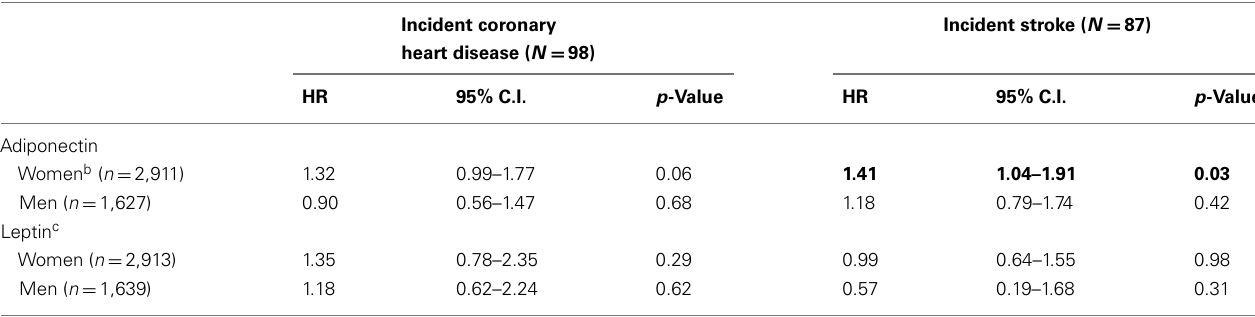
Table 3 |Associations a of adiponectin and leptin with incident coronary heart disease and stroke in the Jackson Heart Study ( N = 4,571). Incident